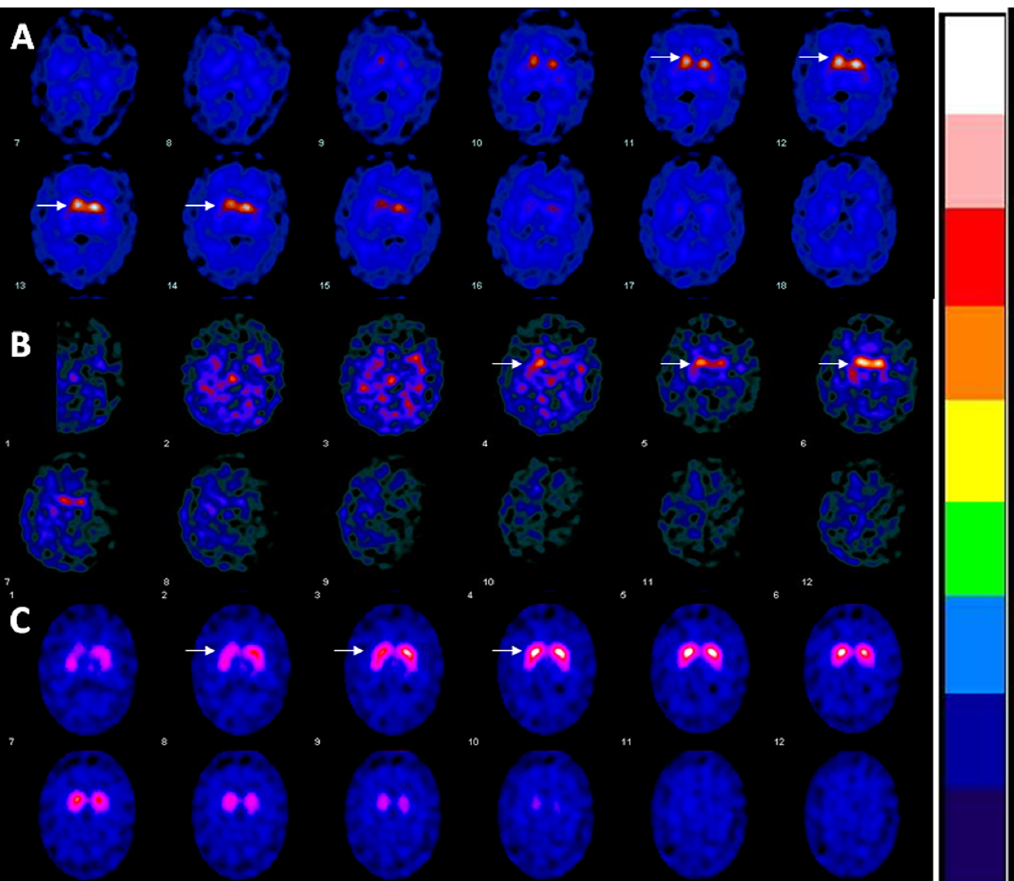
Figure 2. The younger sibling’s DaT ‐ SPECT images (Rows ( A )) shows asymmetrically decreased activity in the putamen bilaterally. The proband’s images (Rows ( B )) show severely reduced uptake in the bilateral putamen with relative preservation in the caudate heads. (Rows ( C )) are DaT ‐ SPECT images from a matched control.